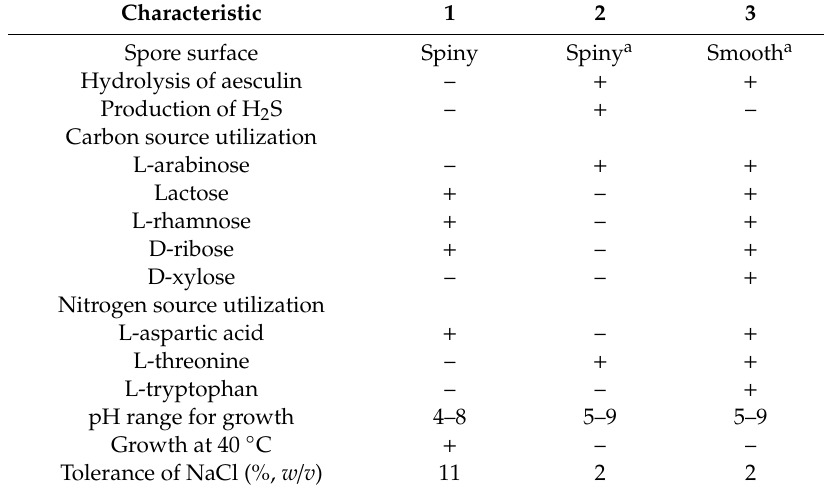
Figure 3. Scanning electron micrograph of strain jys28 T grown on ISP 3 agar for 4 weeks at 28 °C. Table 1. Differential characteristics of strain jys28 T and its closely related strains. Strains: 1, jys28 T ; 2, S. chattanoogensis DSM 40002 T ; 3, S. lydicus NBRC 13058 T . All data are from this study except as labeled. a Data from Kim et al. [43]. +, positive; –, negative.